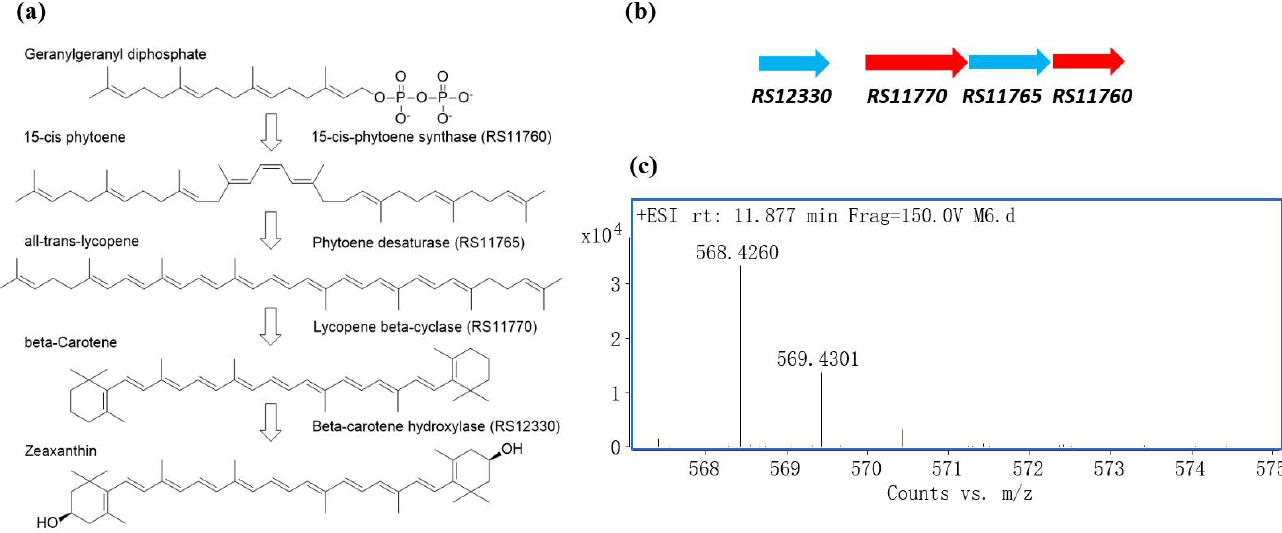
Figure 7. Amino acid sequence alignment of the six ARHDs showing the consensus pattern: C-x- H-R-[GAR]-x(7,8)-[GEKVI]-[NERAQ]-x(4,5)-C-x-[FY]-H, in which the 2 C’s and the 2 H’s are 2Fe- 2S ligands [39]. Asterisks (*) indicate positions which have a single, fully conserved residue, a: (colon) indicates conservation between groups of strongly similar properties, a. (period) indicates conservation between groups of weakly similar properties. Subsequently, ClassicRAST-based functional gene subsystem clustering analysis re- vealed 19 ORFs involved in the metabolism of aromatic compounds (Figure S7) [40]. Con- sidering that the Sphingomonas oligophenolica JCM 12082 T , a strain with a 16S rDNA se- quence similarity of 94.6% to M6 T , was reported to degrade phenolic acids at low concen-